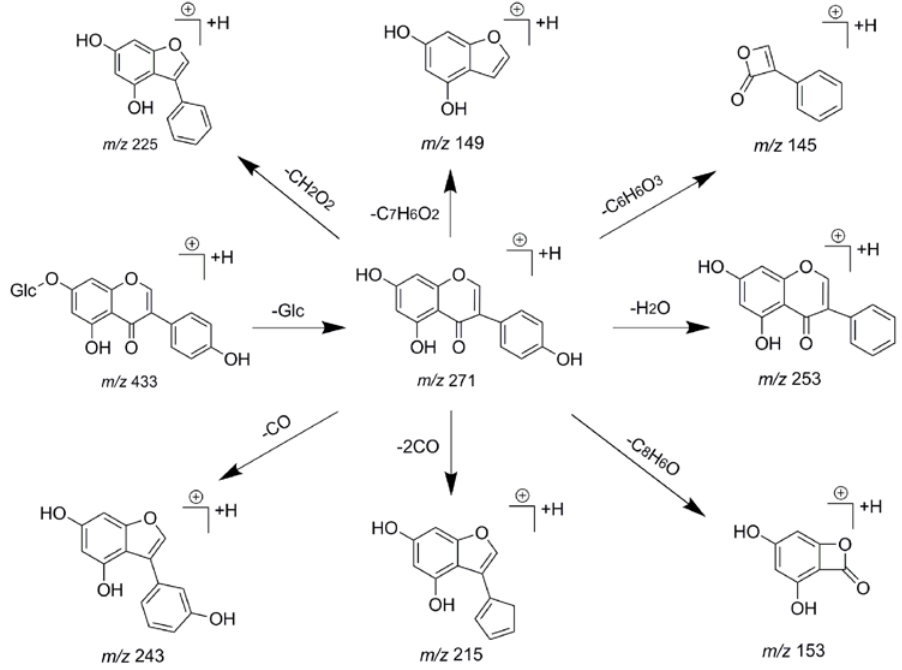
Figure 3. The fragmentation behavior of genistin in positive ion mode.